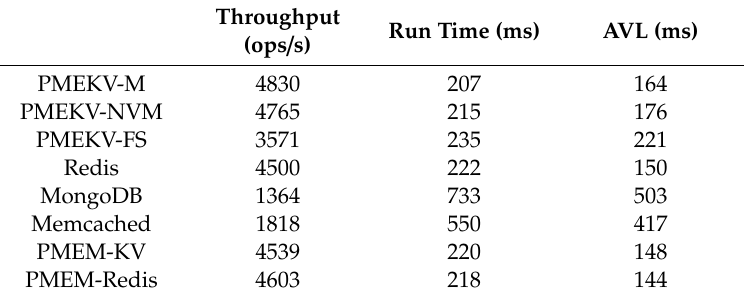
Table 1. The results of key–value pairs